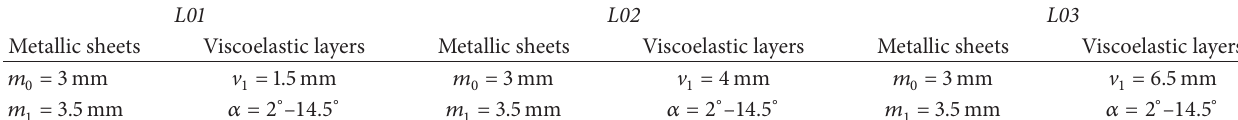
Table 8: Geometric parameters of the three mono-layer damper designs.